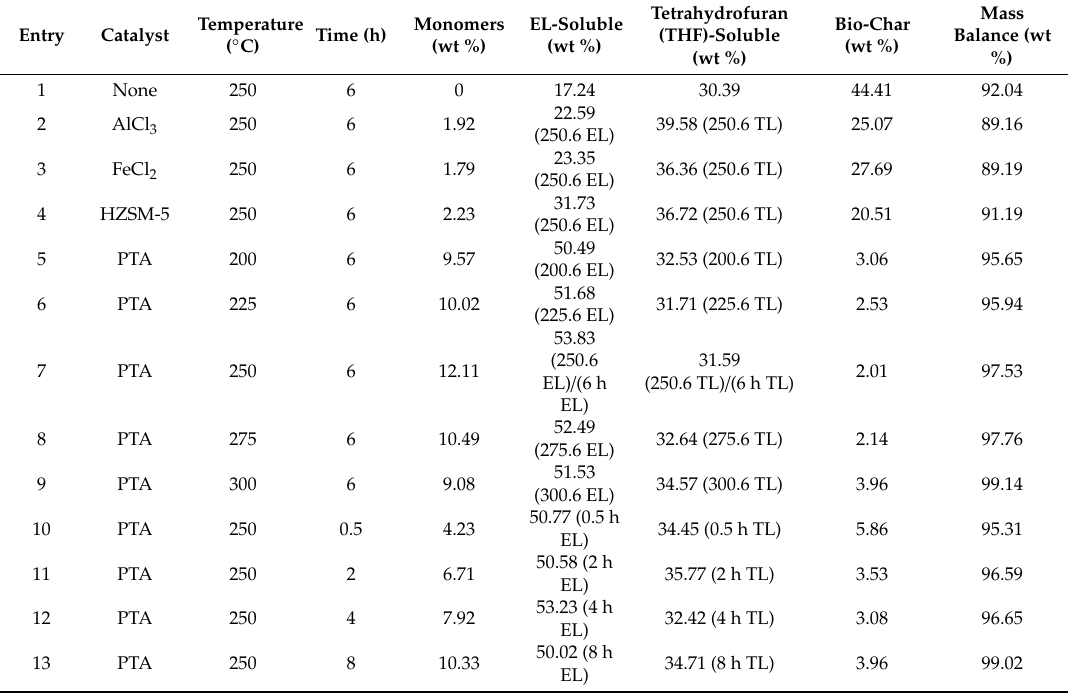
Figure 2. The Fourier transform infrared spectroscopy (FT–IR) spectra, TGA, gel permeation chromatography (GPC), and elemental analysis of the BL. ( a ) The FT–IR spectra; ( b ) the TGA; ( c ) the GPC; and ( d ) the elemental analysis. Table 1. The mass balance of catalytic depolymerization products under di ff erent reaction